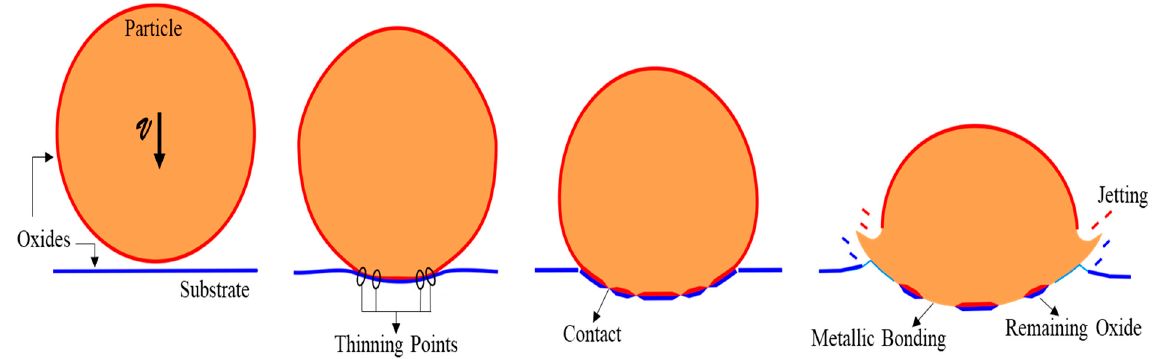
Figure 6. Schematic showing the bonding mechanism of a typical cold spray process.